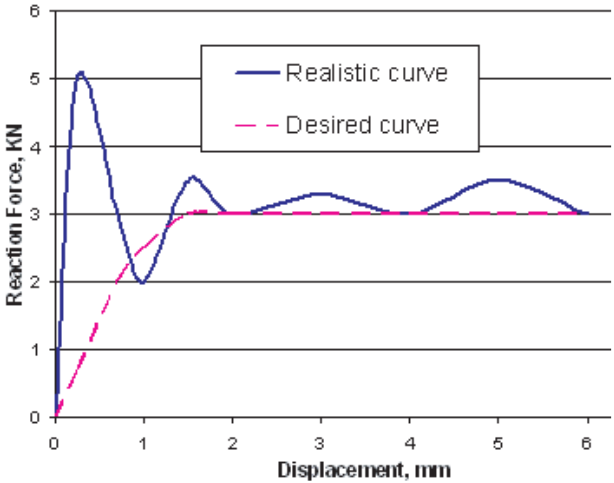
Fig. 2. Force-displacement diagram of energy absorbing com- ponent: realistic curve and desired curve.